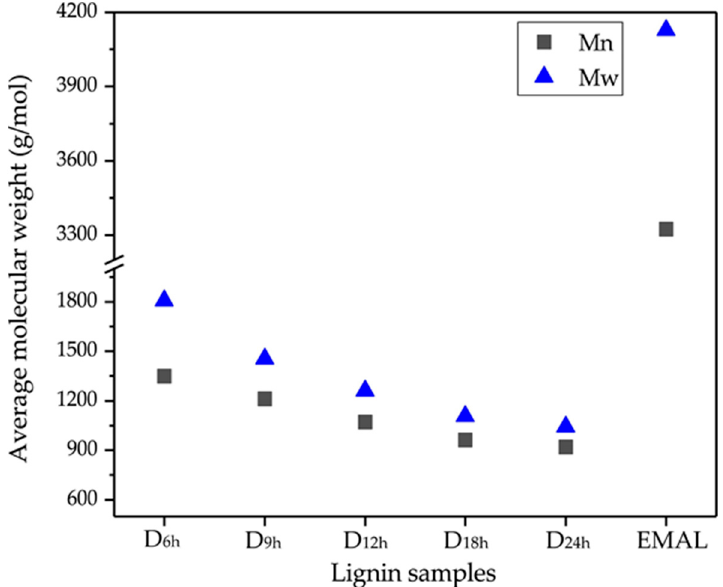
(cid:0) (cid:1) M w of